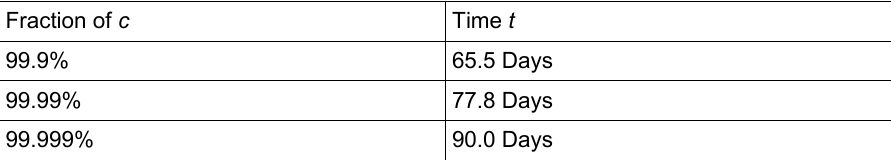
c = 125043 obtained in Table